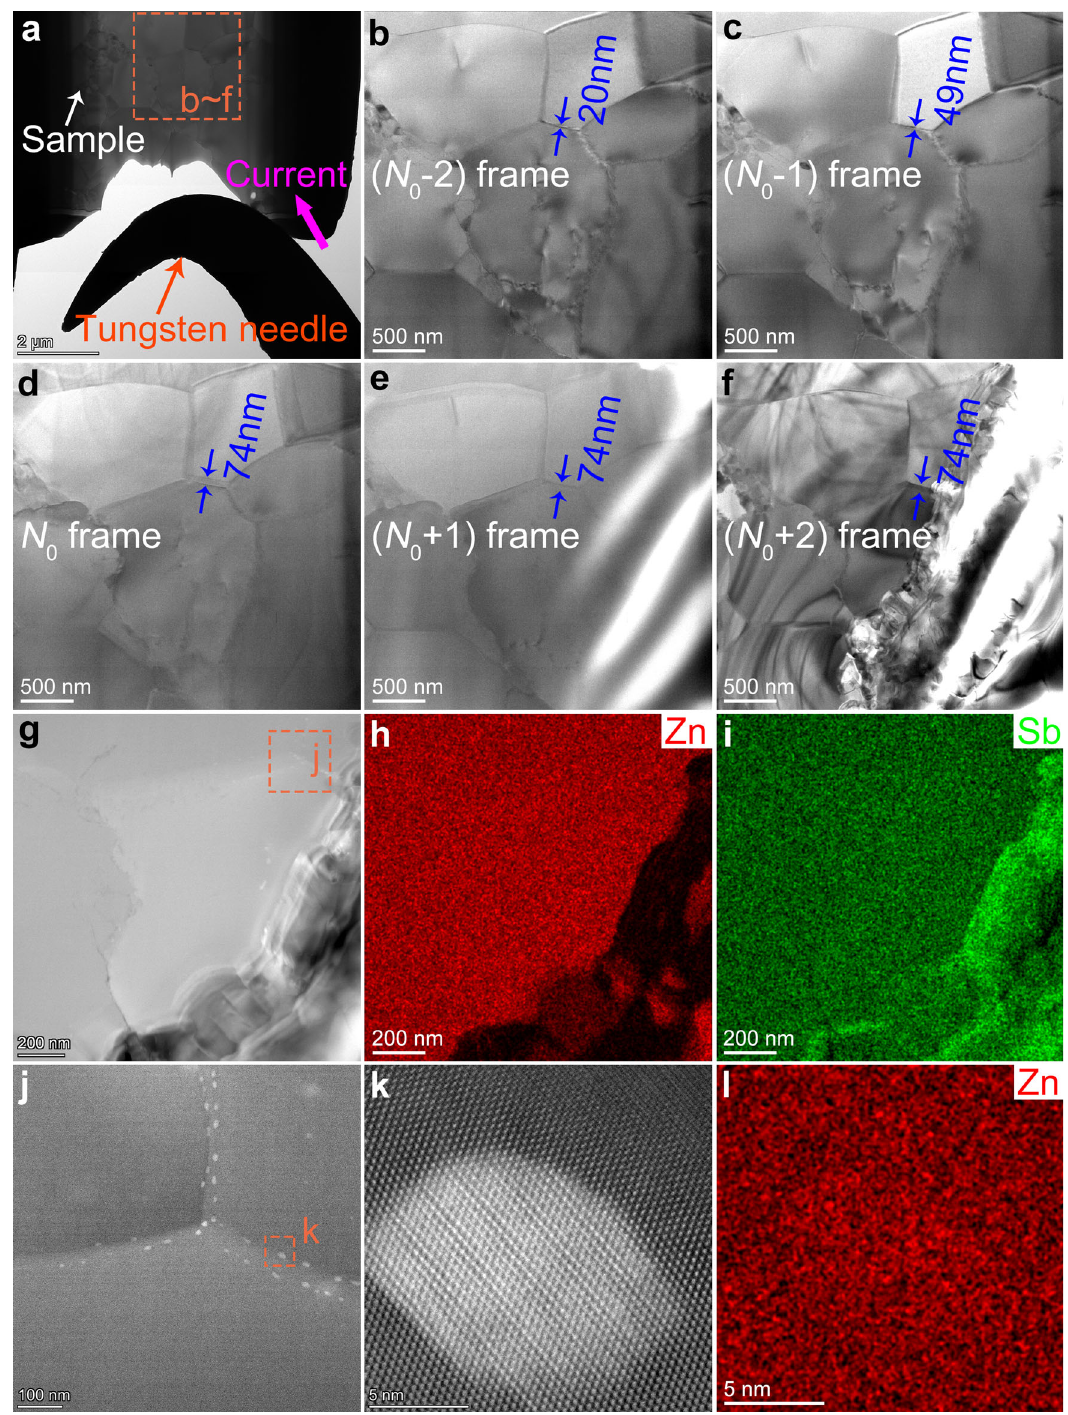
Fig. 4 In situ microstructure evolution. a – f Different stages (in time) during the current fl ow through the EFAS Zn 4 Sb 3 sample (the grain boundary reaches the widest at the N 0 frame). g – i The HAADF image and the corresponding EDS spectrum of EFAS Zn 4 Sb 3 sample after the current are turned off. j Enlarged HAADF image of the grain boundary area delineated by an orange border in ( g ); white particles are precipitated at the junction of the two grains. k – l High- resolution images and EDS spectra of white